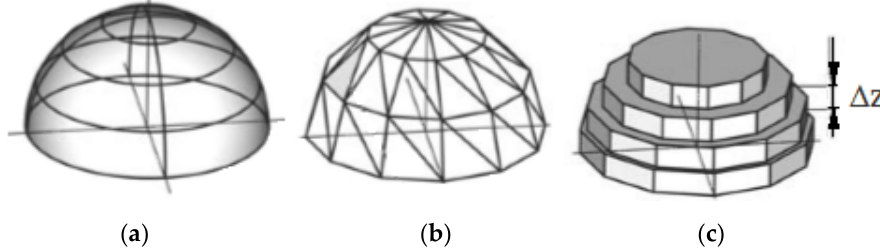
Figure 1. Scheme of the stereolithography (SLA) printing process: ( a ) CAD model, ( b ) STL model, and ( c ) division into slices. Δ z—layer thickness.